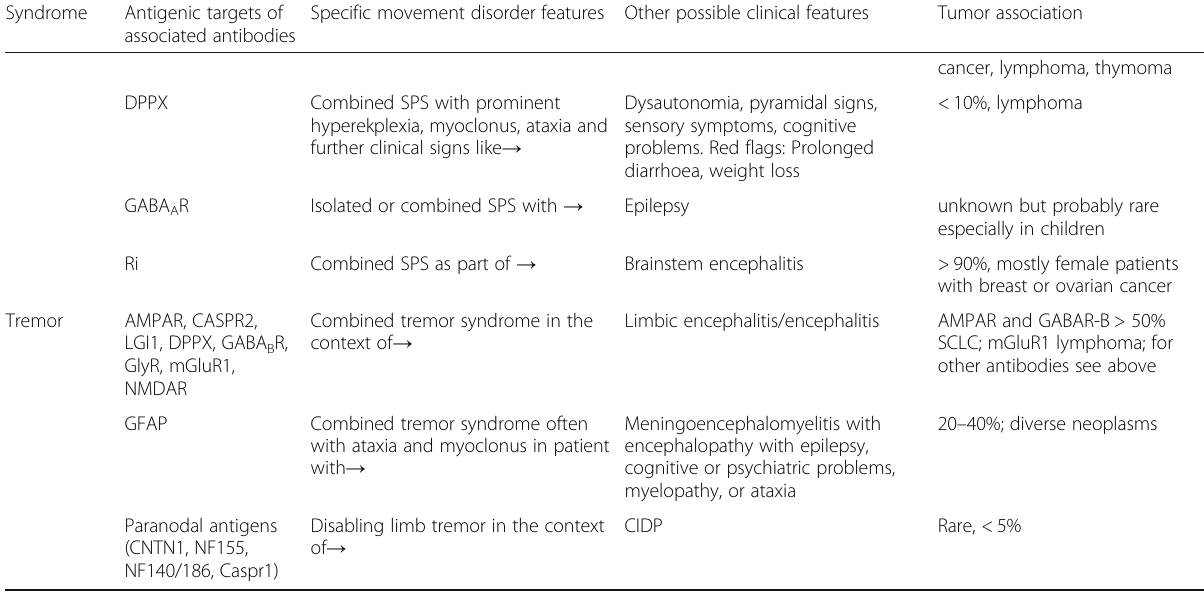
Table 1 Antibody-related movement disorders: Clinical features and tumor association (Continued) Syndrome Antigenic targets of Specific movement disorder features Other possible clinical associated antibodies